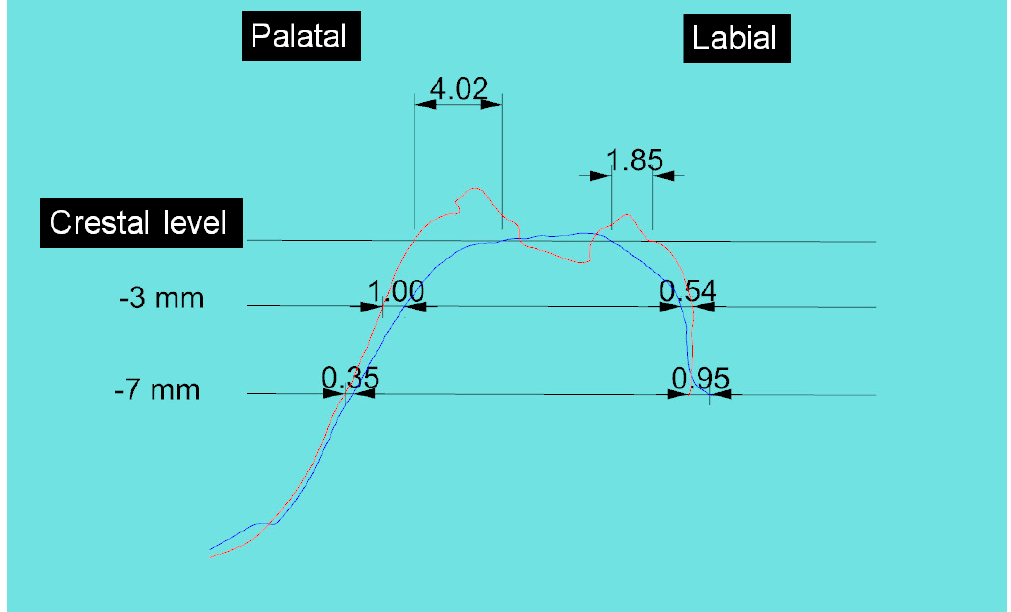
Figure 8. Sagittal superimposition of pre/post models with linear variation at the crestal level, at 3 mm and 7 mm from the crest.